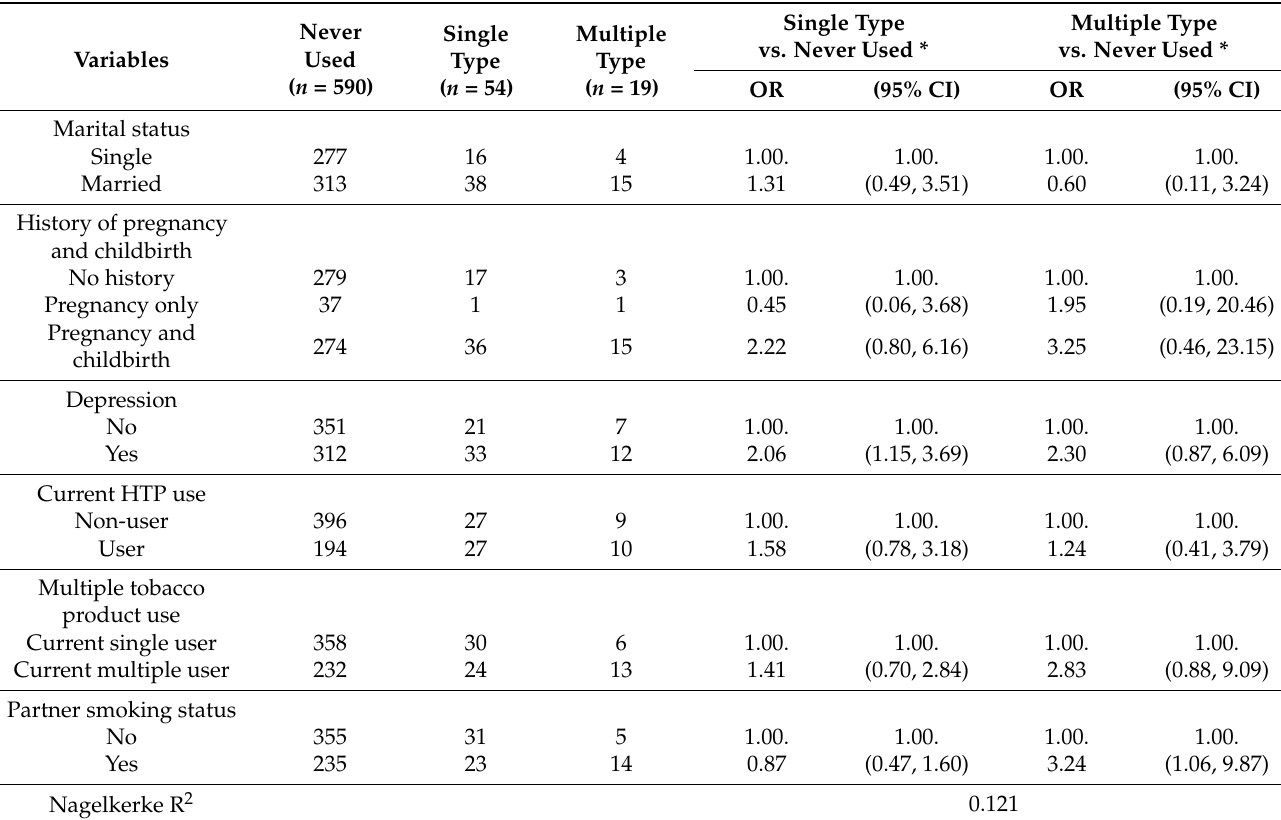
Table 3. Multinomial logistic regression analysis of factors associated with the number of utilized service type ( n =